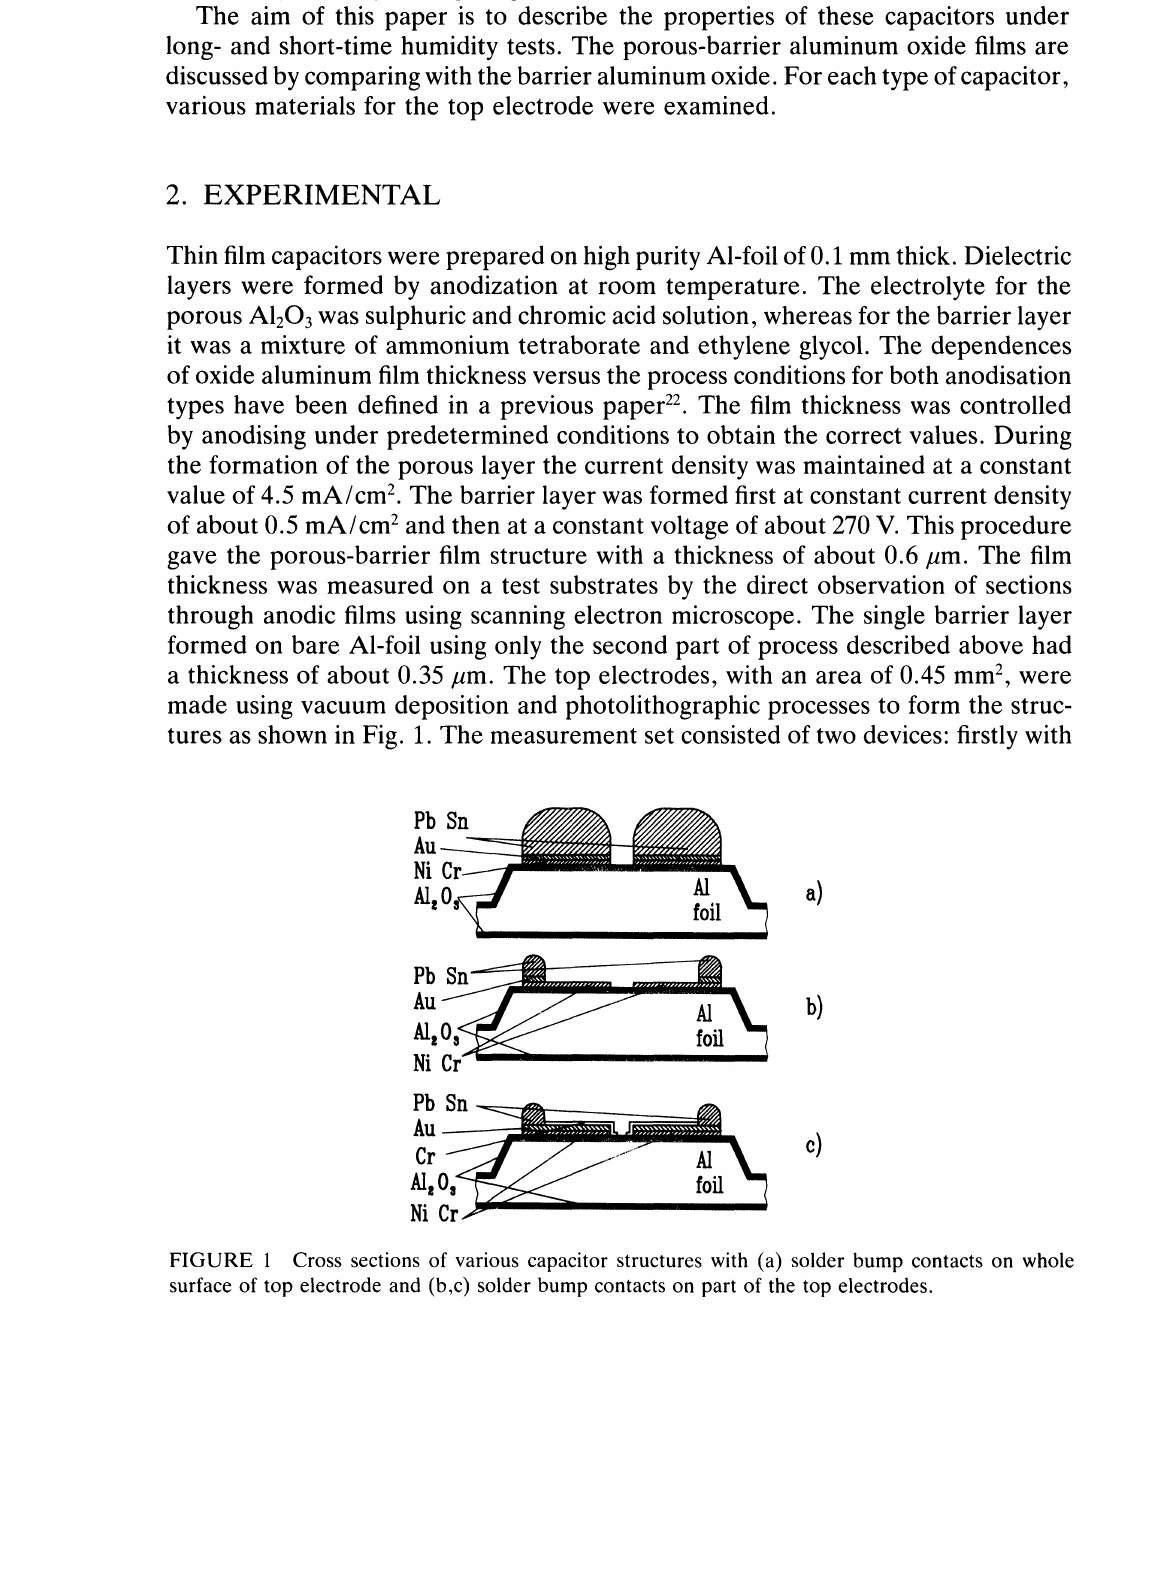
Cross sections of various capacitor structures with (a) solder bump contacts on whole surface of top electrode and (b,c) solder bump contacts on part of the top